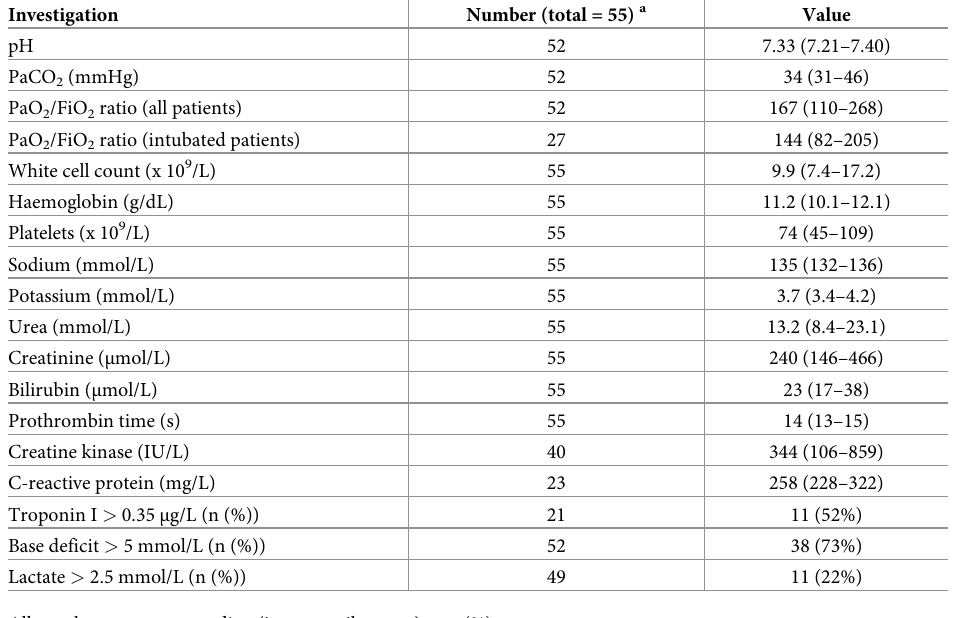
All numbers represent median (interquartile range) or n (%) a Not all investigations were performed in every patient https://doi.org/10.1371/journal.pntd.0007929.t003 were required in 27/55 (49%) patients (Table 6), 7 (26%) of whom required intubation at a regional hospital prior to transfer to Cairns Hospital. Prone ventilation was employed in 4/27